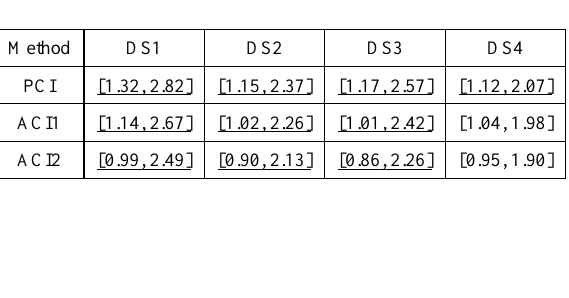
Table 7. The estimation results of model parameter 𝜅 with